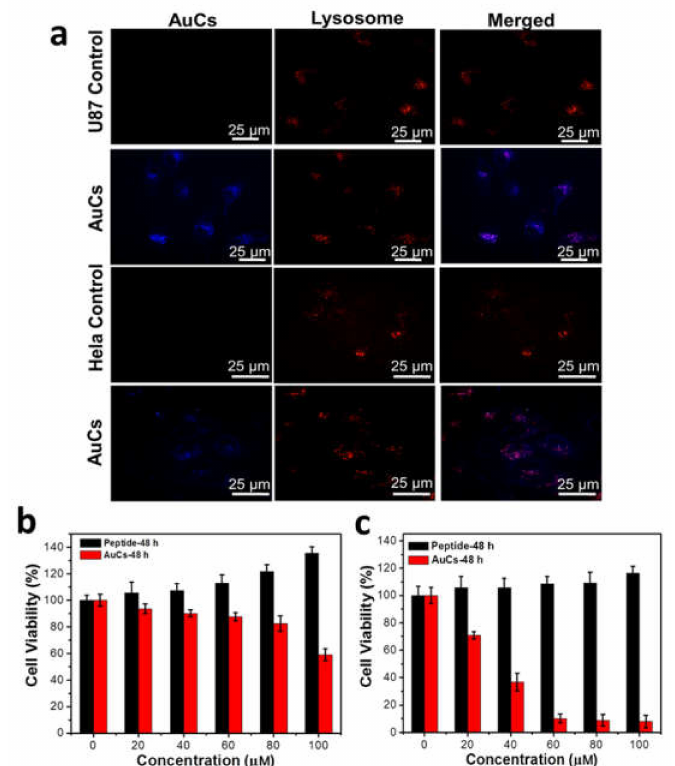
Figure 3. ( a ) Intracellular localization of AuCs in U87-MG and HeLa cells pre-treated for 12 h. Cytotoxicity of HeLa cells ( b ) and U87-MG cells ( c ) treated by AuCs and peptide alone for 48 h (n = 5 per dose group). The peptide concentration is calculated by the ratio of peptide to gold on the basis of the corresponding AuCs